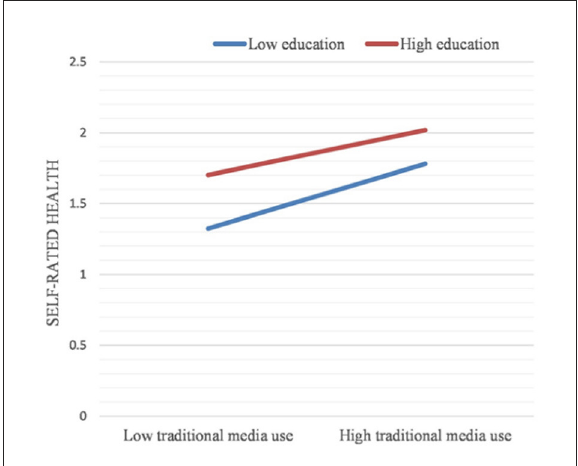
FIGURE3 Simple slope plot for the interaction between traditional media use and education (Dependent variables: Subjective well-being).